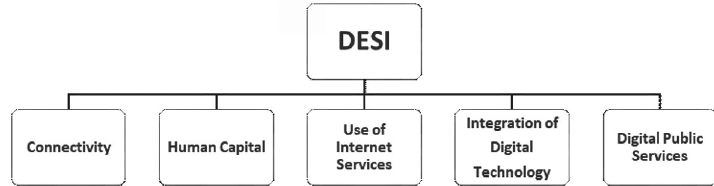
Figure 1. Five dimensions representing main policy areas in